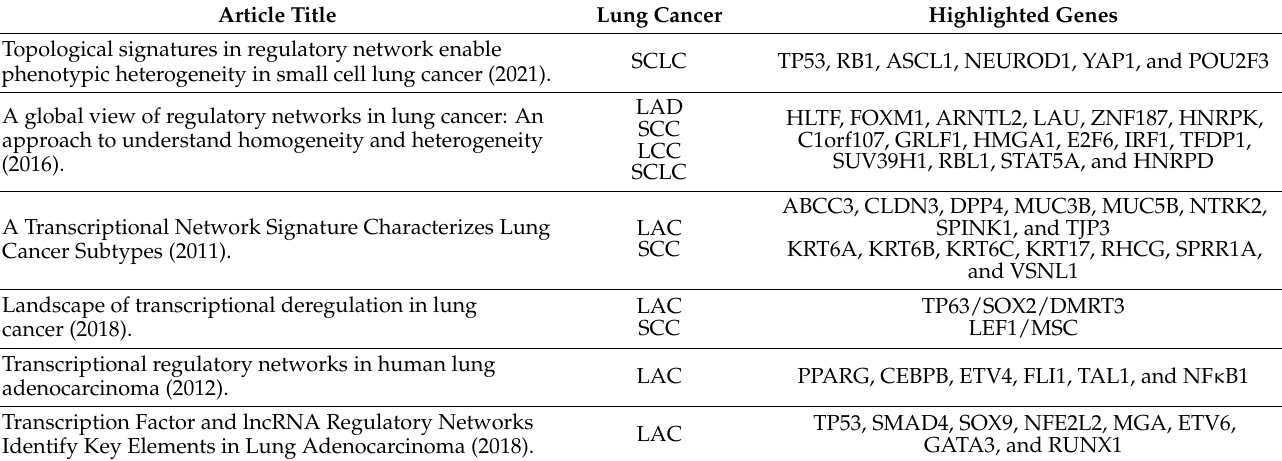
Table 4. Previous gene transcriptional and regulatory network analyses of lung